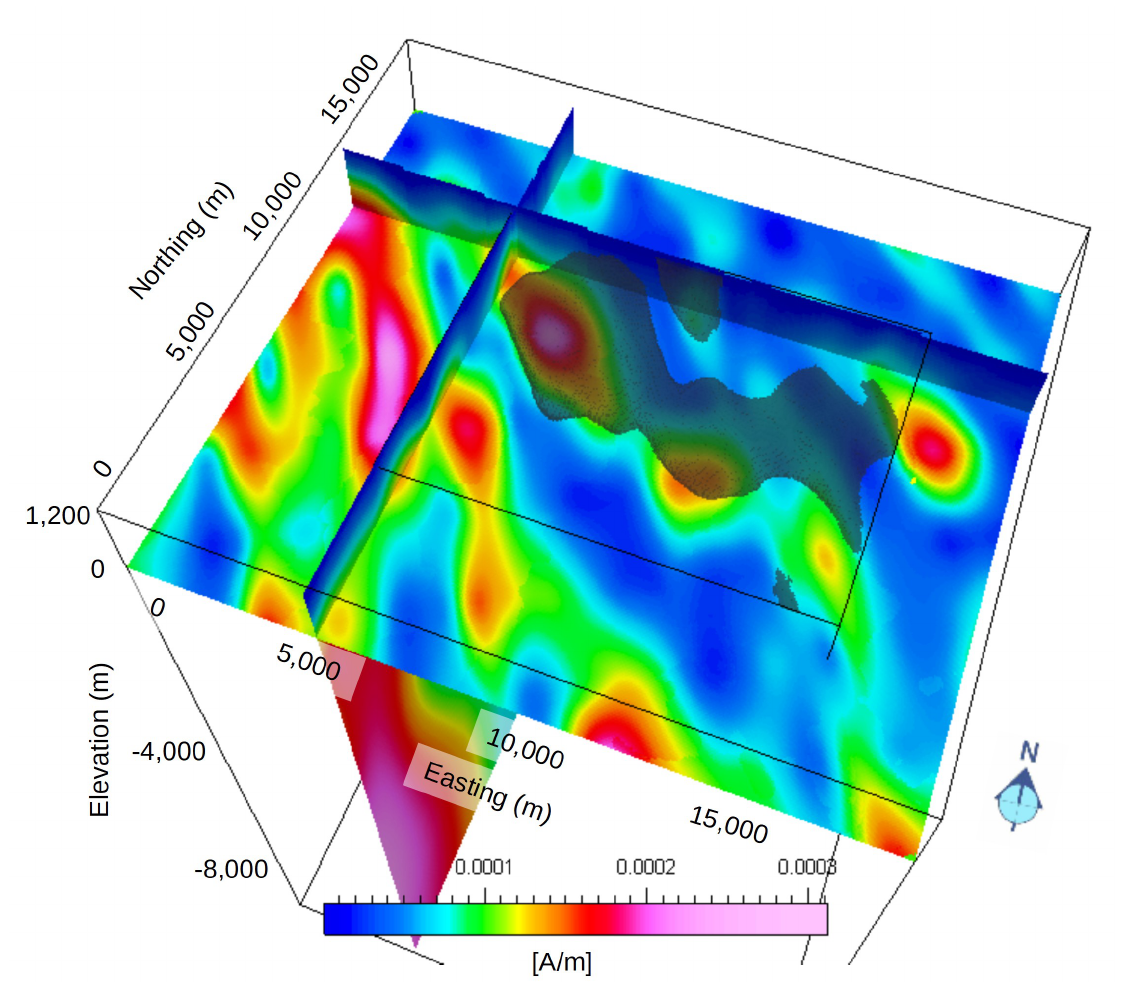
Figure 11. Combined conductivity and magnetic images of the same anomaly shown in Figure 10. Voxels with conductivities greater than 100 mS/m are shown, but the cross sections represent magnitude of the magnetic vector model. The correlation between the magnetics and conductivity are